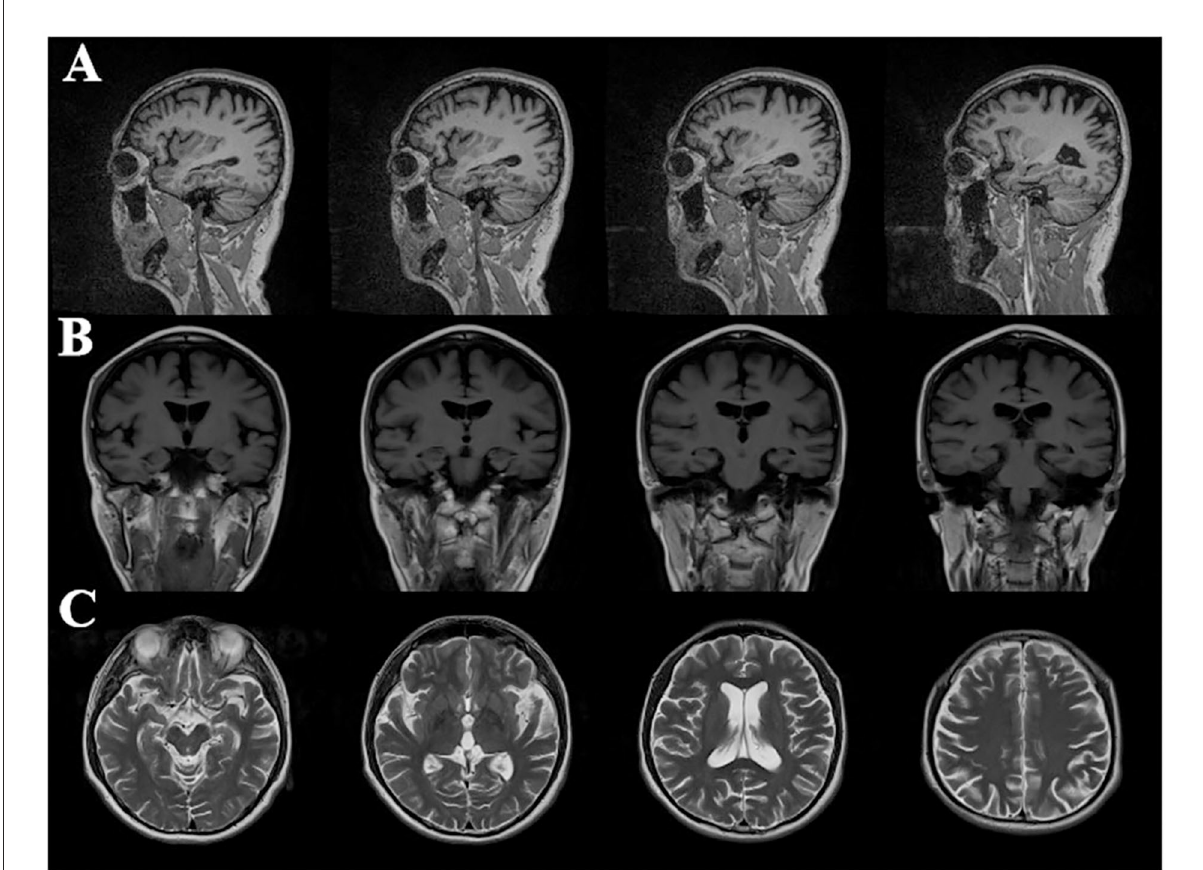
FIGURE1 Cranial magnetic resonance imaging in patients with Alzheimer’s disease: (A) sagittal image of T2 fluid attenuated inversion recovery (T2 FLAIR); (B) coronal image of T1-weighted image (T1WI); (C) cross-sectional sequences of T2-weighted image (T2WI); imaging results showed atrophy of bilateral temporal parietal lobe and posterior cingulate gyrus, and dilatation of ventricle, cistern, fissure, and